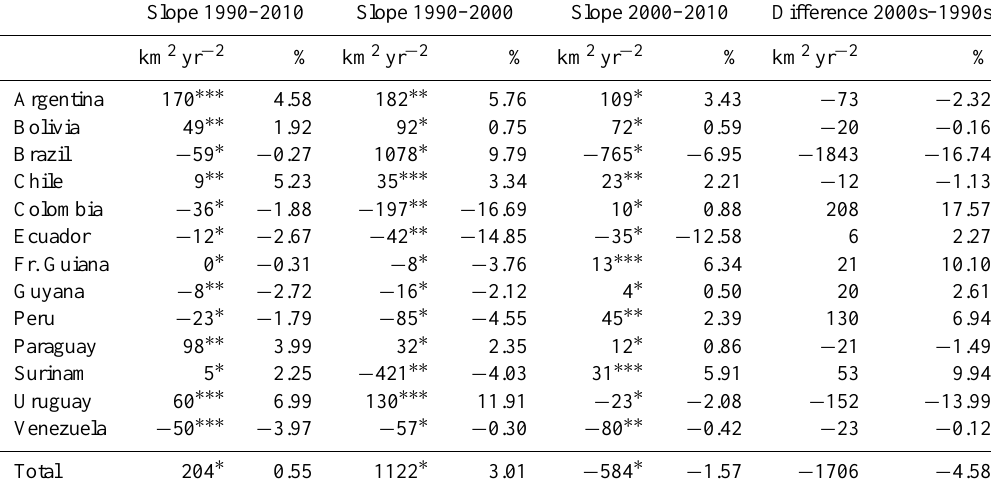
Table 3. Trends in forest loss based on VOD for the whole time period (1990–2010) and the decades 1990–2000 and 2000–2010. Absolute values indicate the slope based on Pearson linear regression and the relative values are the absolute values relative to the average forest loss for that country over the full 21-year time period. Asterisks indicate the significance, where ∗ = p >0.25; ∗∗ = p <0.25; ∗∗∗ = p <0.05.